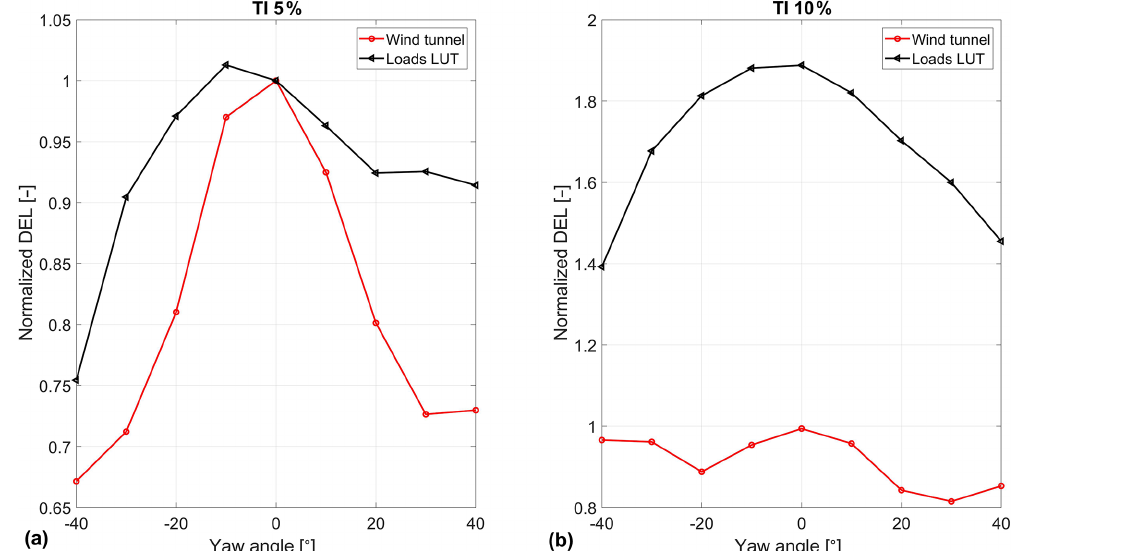
Figure 5. CL-Windcon and load module tower base fore–aft moment as a function of yaw, for low turbulence (a) and high turbulence (b) .